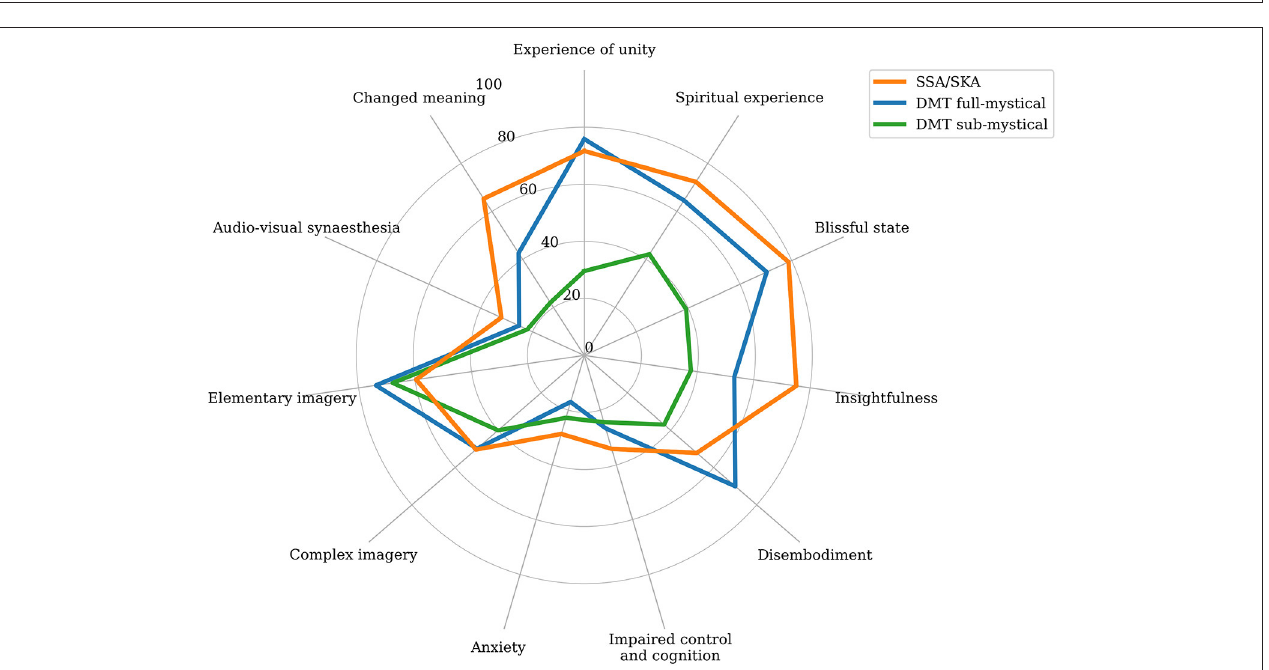
FIGURE 5 | Radar chart comparing the mean subscale scores of the 11-Dimensional Altered States of Consciousness Rating Scale (11D-ASC; Studerus et al., 2010) for the participants of this study (SSA/SKA; N = 152); high dose N,N- dimethyltryptamine complete mystical experience (DMT full-mystical; 40–75mg; N = 21; Luke, 2019); and high dose N,N- dimethyltryptamine sub-mystical experience (DMT sub-mystical; 40–75mg; N = 14; Luke, 2019), as defined by the 30-item Mystical Experience Questionnaire (MEQ30; MacLean et al., 2012).